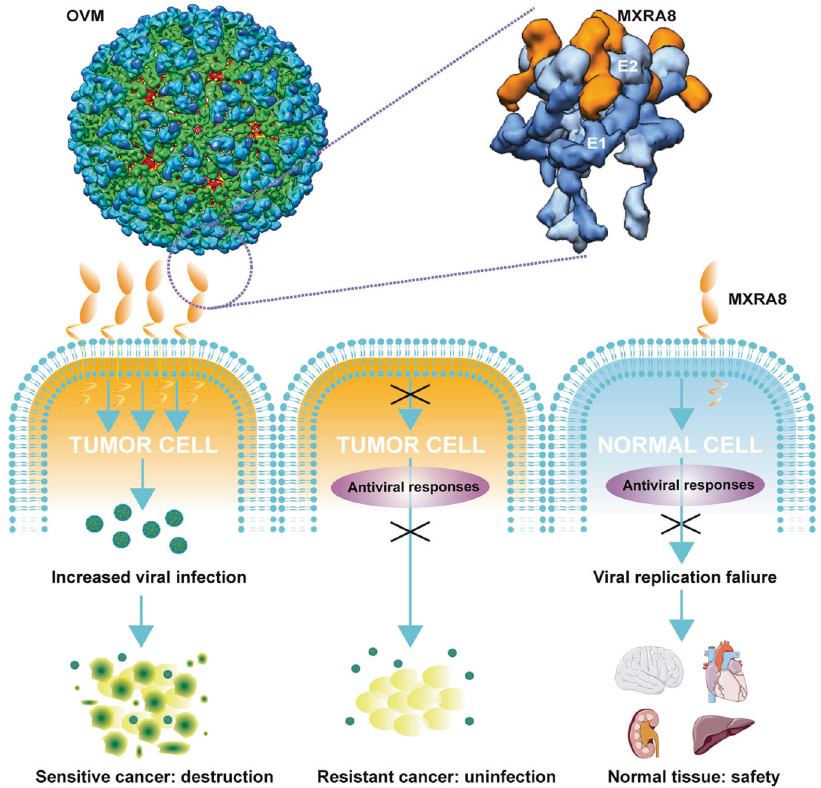
Fig. 7 Graphical model of the tumor selectivity of OVM. OVM is a 680 Å diameter icosahedral particle with 80 trimeric spikes that assembled by 240 embedded E2 – E1 heterodimers in a lipid bilayer. The E2 – E1 heterodimers could directly bind MXRA8 on tumor cells, thus mediate the entry and internalization of OVM virions. OVM could effectively infect tumor cells with MXRA8 expression and a permissive intracellular environment for viral replication, which eventually lead to the lysis of tumor tissue. However, active antiviral responses, such as ZAP, and lack of MXRA8 also make some tumor cells resistant to OVM infection. In addition, the low expression of viral receptors and antiviral activities works together to build the safety of OVM in normal tissues. Above all, the tumor selectivity of OVM is mediated by the entry receptor